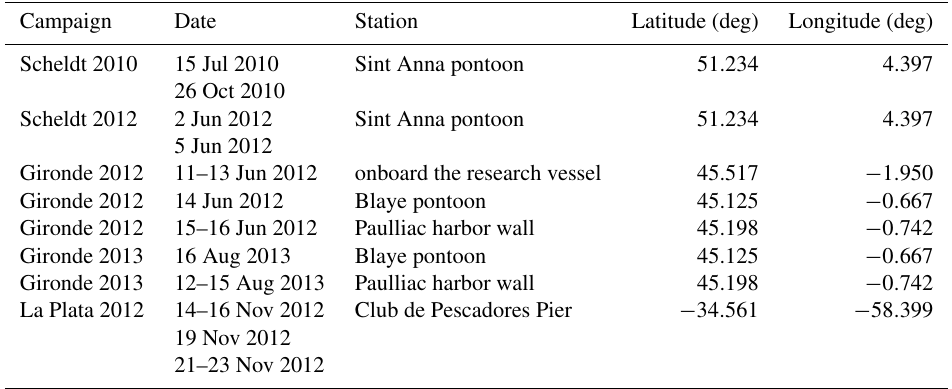
Table 1. Date and location of in situ campaigns. Campaign